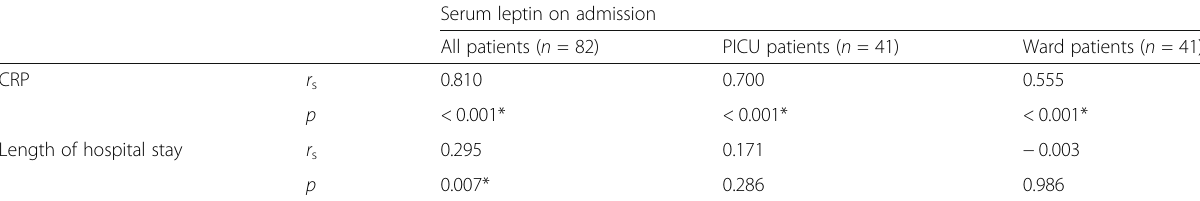
Table 4 Correlation between the serum leptin level, CRP, and length of hospital stay